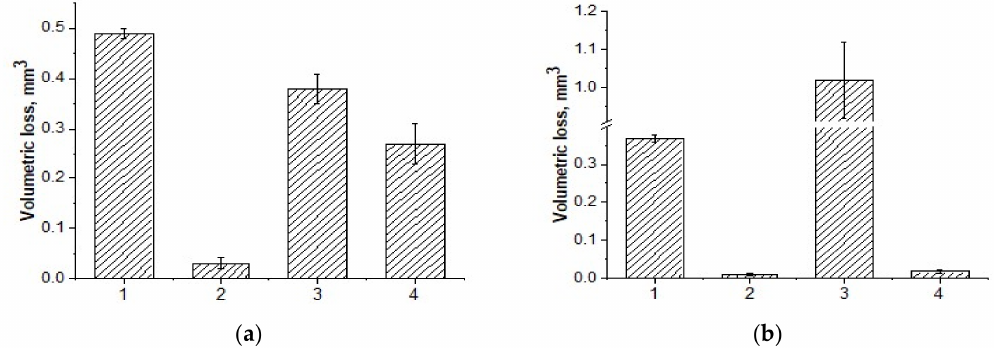
Figure 9. Volumetric wear: ( a ) on the metal counterpart and ( b ) on the ceramic counterpart (1–PPS, 2–PPS + 15% PTFE, 3–PPS + 20% CF, 4–PPS + 15% PTFE + 22.5%